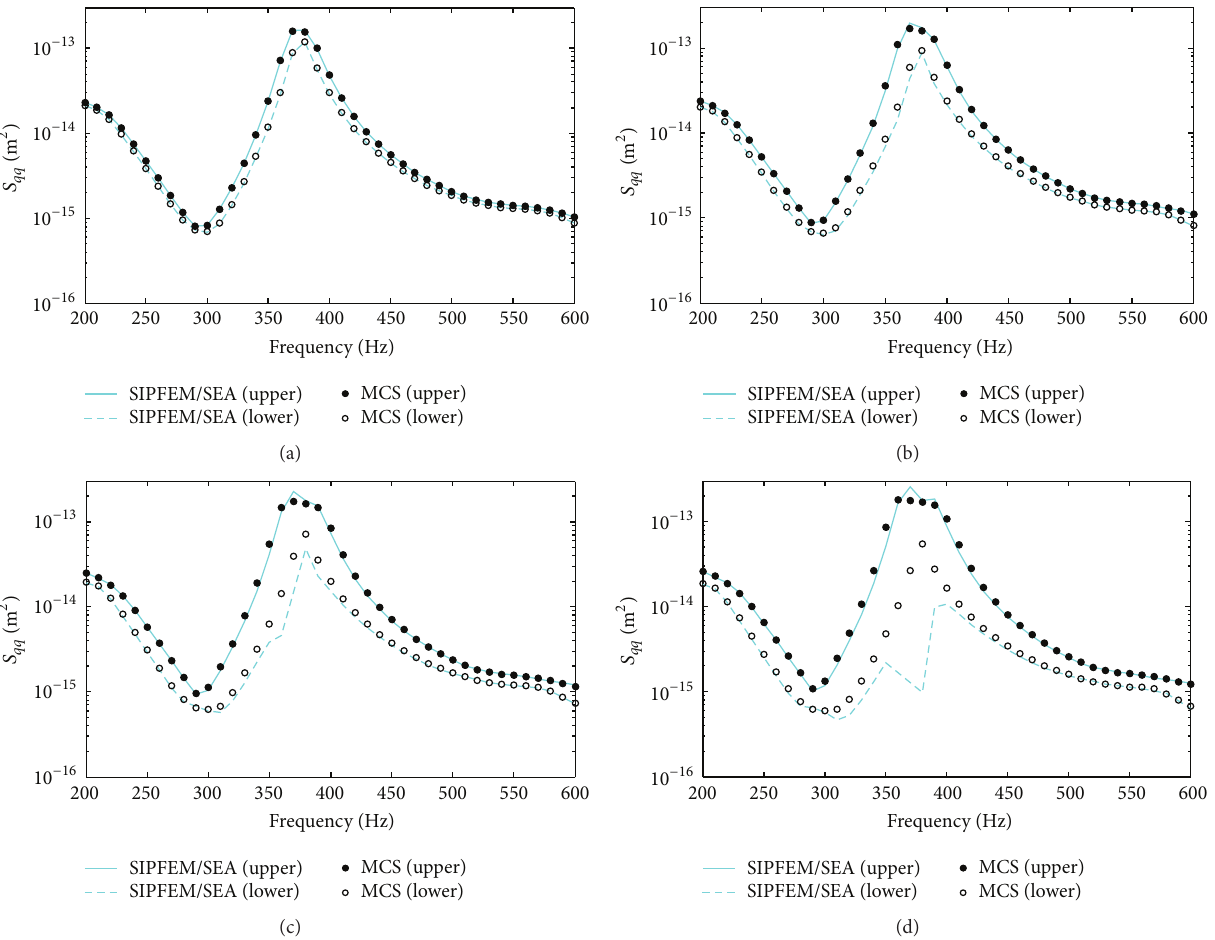
Figure 8: The bounds of the autospectra of the driving point displacements: (a) 𝛼 = 0.01 ; (b) 𝛼 = 0.02 ; (c) 𝛼 = 0.03 ; (d) 𝛼 = 0.04 .